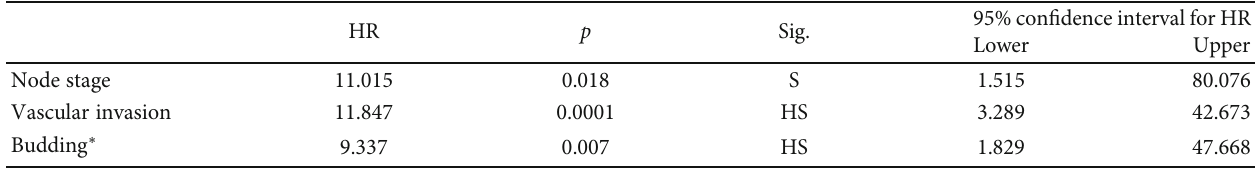
Table 4: Backward multivariate Cox regression for evaluating the e ff ect of prognostic histopathologic parameters and tumor budding on progression-free survival.